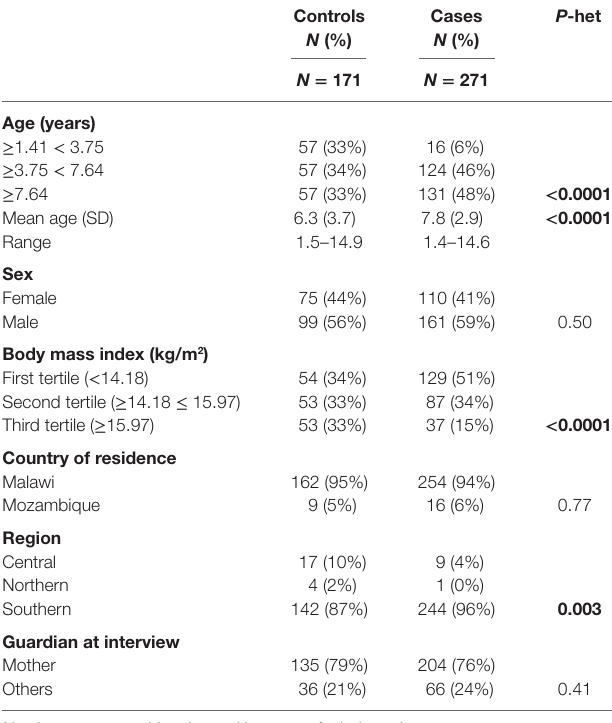
TaBle 1 | Basic demographic characteristics of study participants.